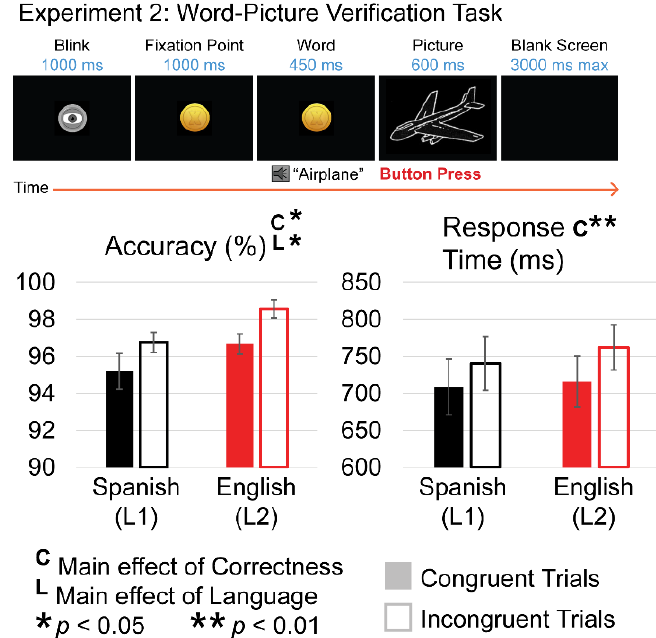
Figure 7. Word–Picture Verification task. An example trial in English showing the trial structure from left to right over time in ms is depicted on the top. Trial structure was identical for the Spanish task. Participants were asked to respond from the onset of the line drawing. Behavioral results for the Word–Picture Verification task are depicted in the bar graphs. Percent accuracy and response time in milliseconds measured from solution onset ( n = 27). Dark bars indicate trials with congruent picture–word pairs and striped bars indicate trials ending with incongruent picture–word pairs. Response time measurements include only trials that participants judged correctly. Significant